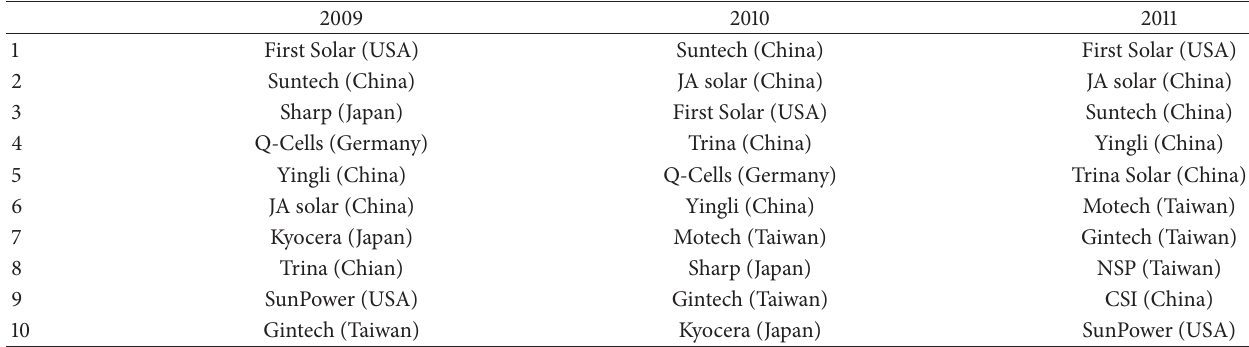
Table 1: Top 10 global solar photovoltaic suppliers.